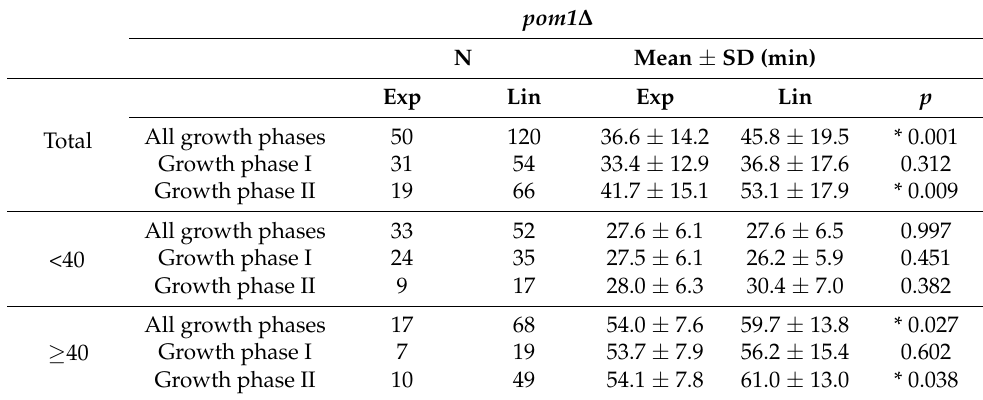
Table 4. Results of the two-sample t -tests for analysing the growing phases in those pom1 ∆ , mutant cells, which grew